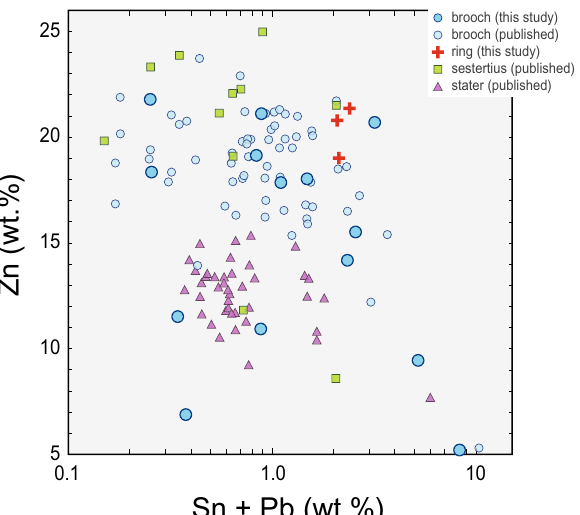
Figure 7. Plot of Zn verus Sn + Pb contents (in wt. %) of the earliest brass artefacts from the first century BC. For categorisation according to dating see Suppl. Figure 3 Sources: 9,10,66 + this study.